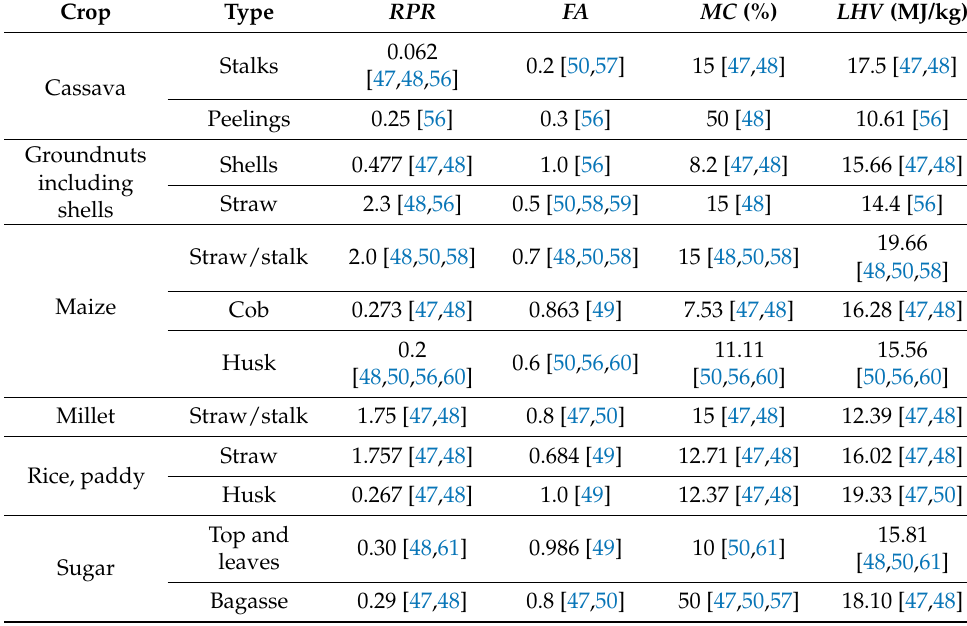
Table 3. Agricultural crop residue